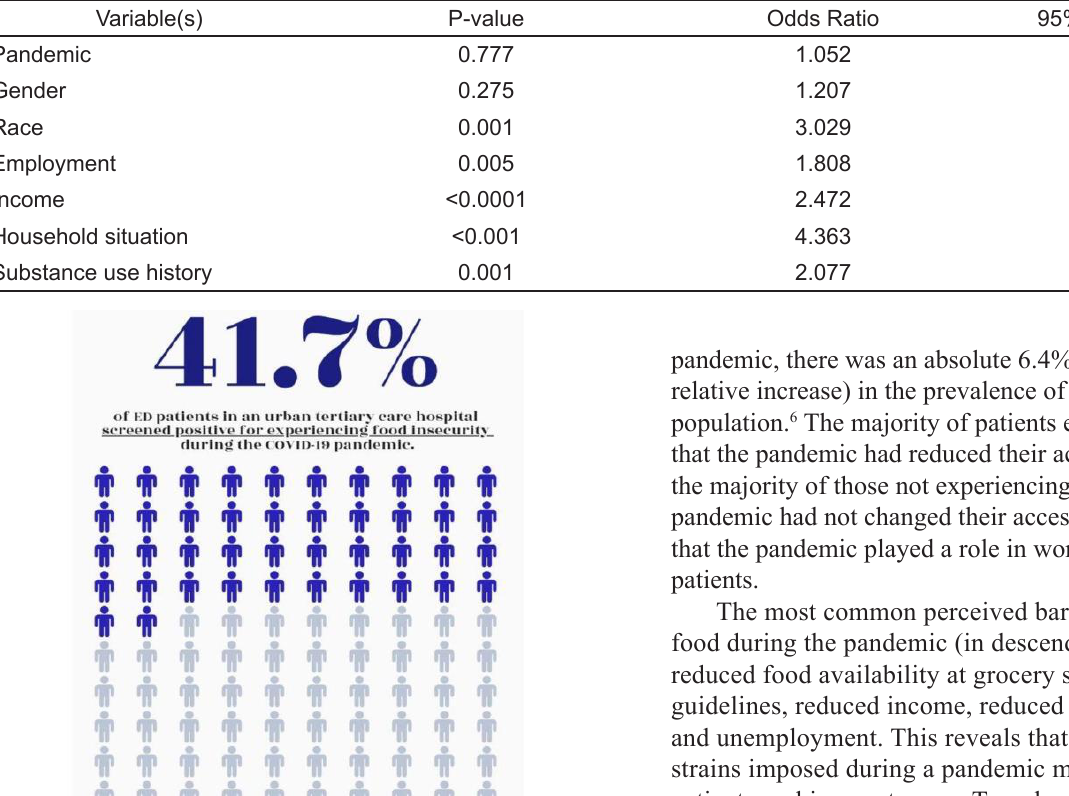
Table 3. Logistic regression.